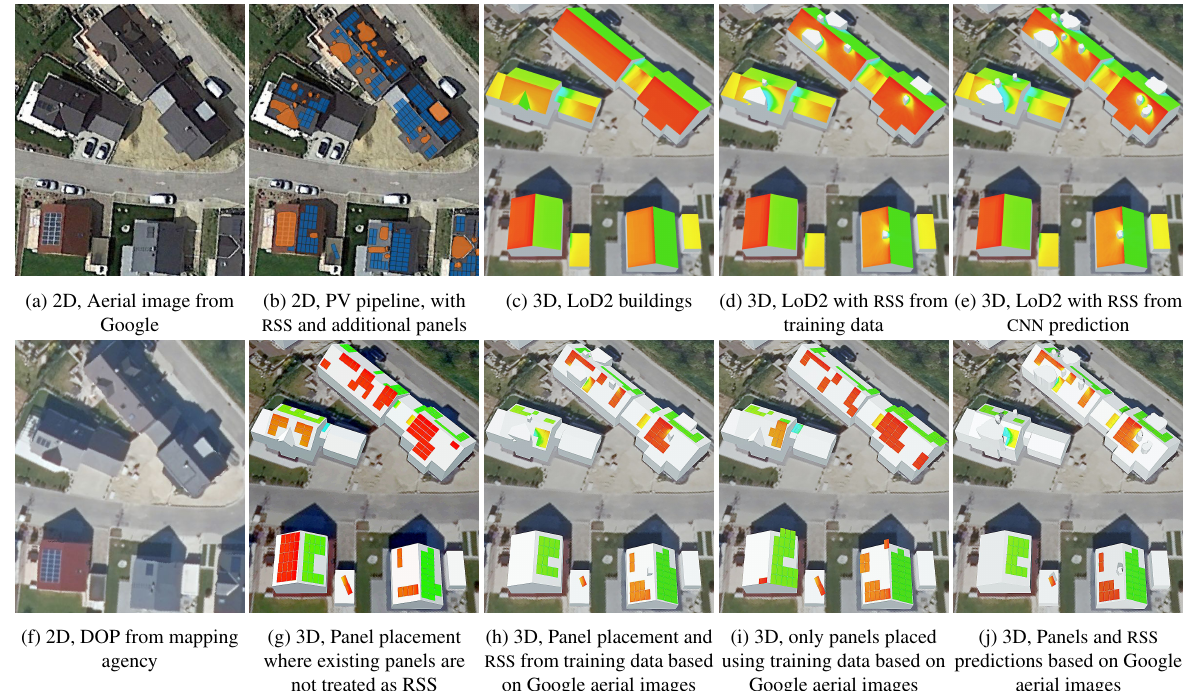
Figure 5. Overview in the input datasets and experiments for the case study.